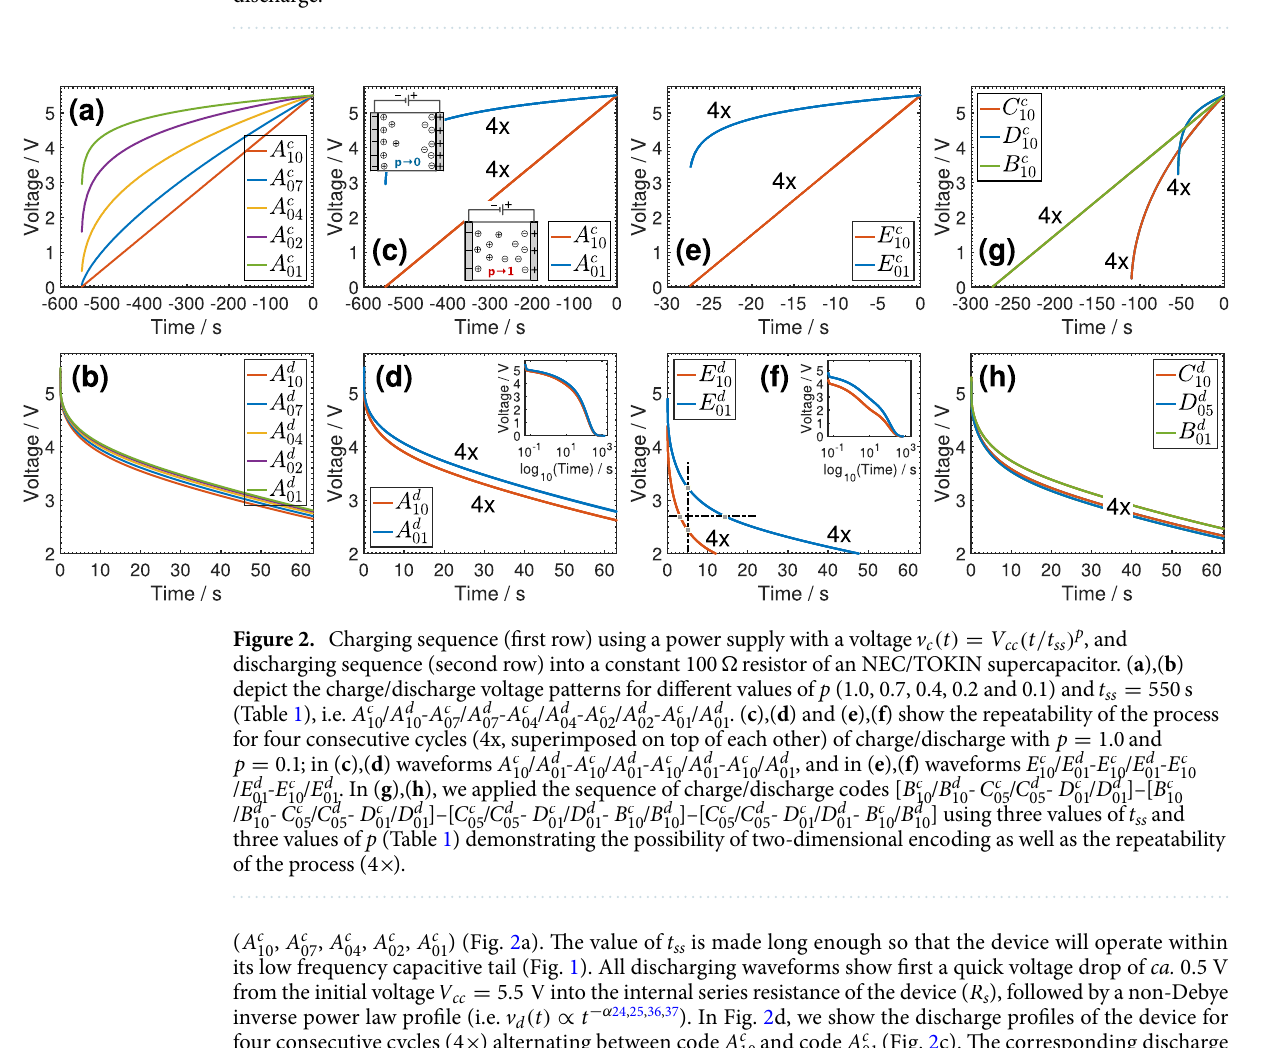
A d A c A d A c A d A c A d 10 / 01 - 10 / 01 - 10 / 01 - 10 / 01 , and in ( e ),( f ) waveforms